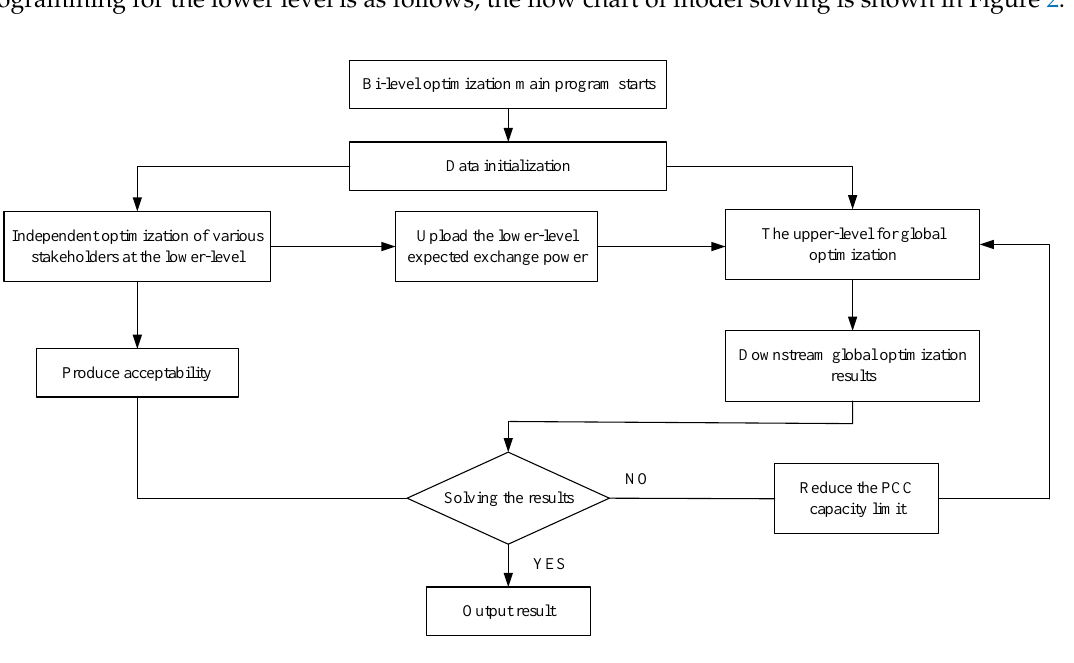
Figure 2. Flow chart of model solving.